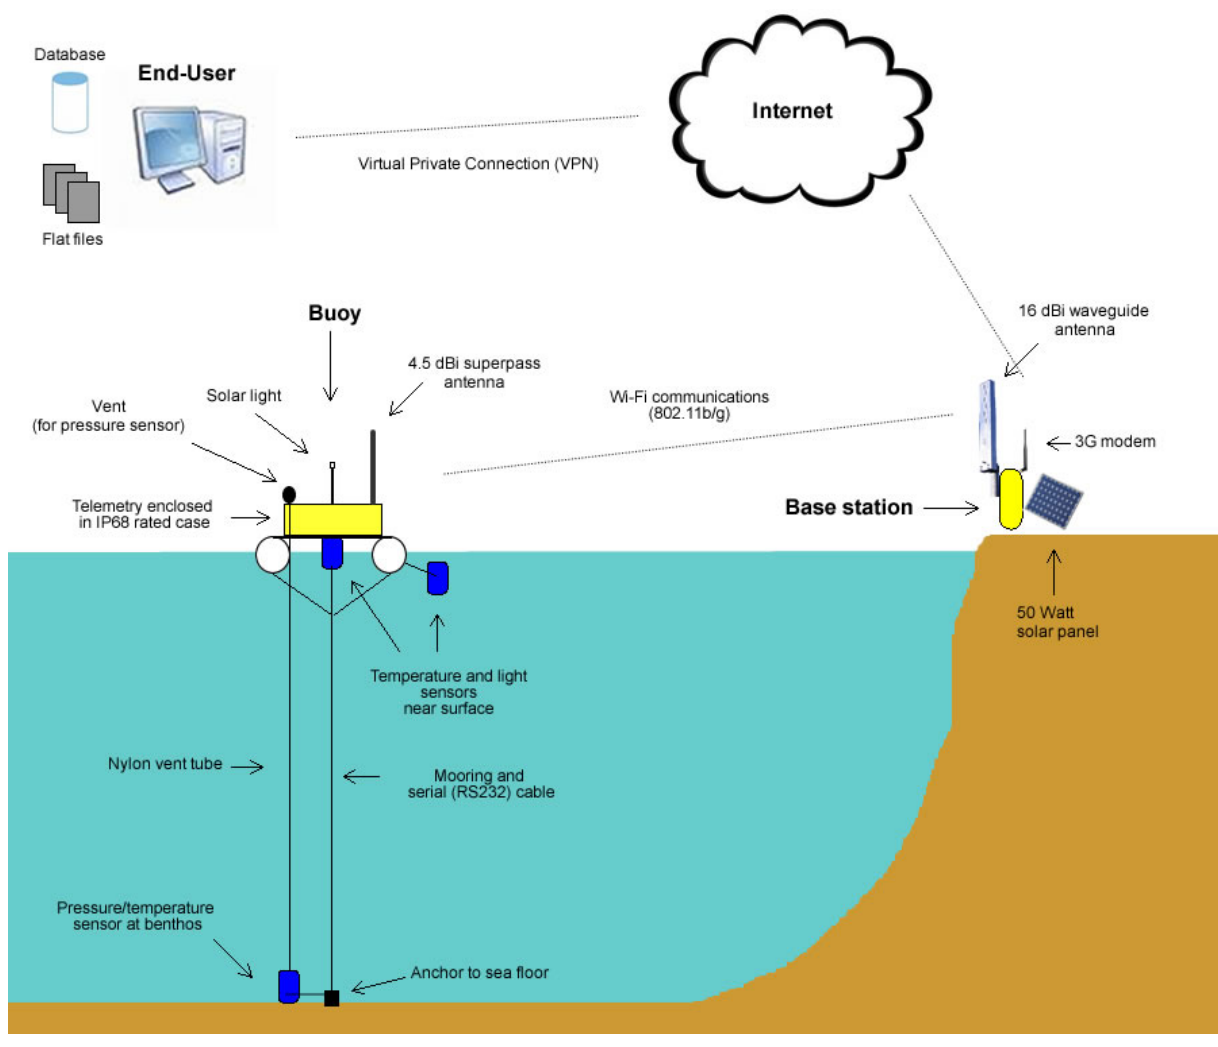
Figure 8. The conceptual setup for the Deception Bay